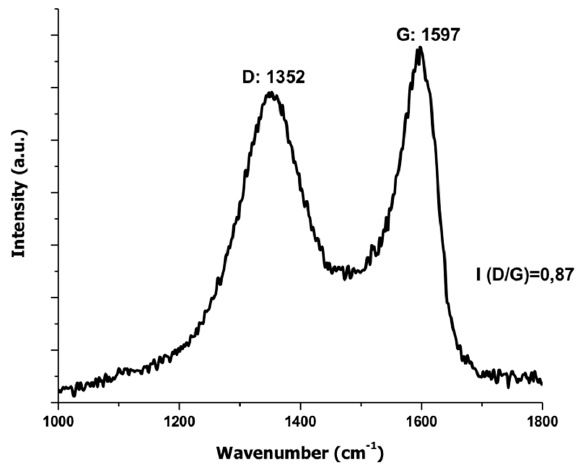
Figure 3. Raman spectrum of graphene oxide.